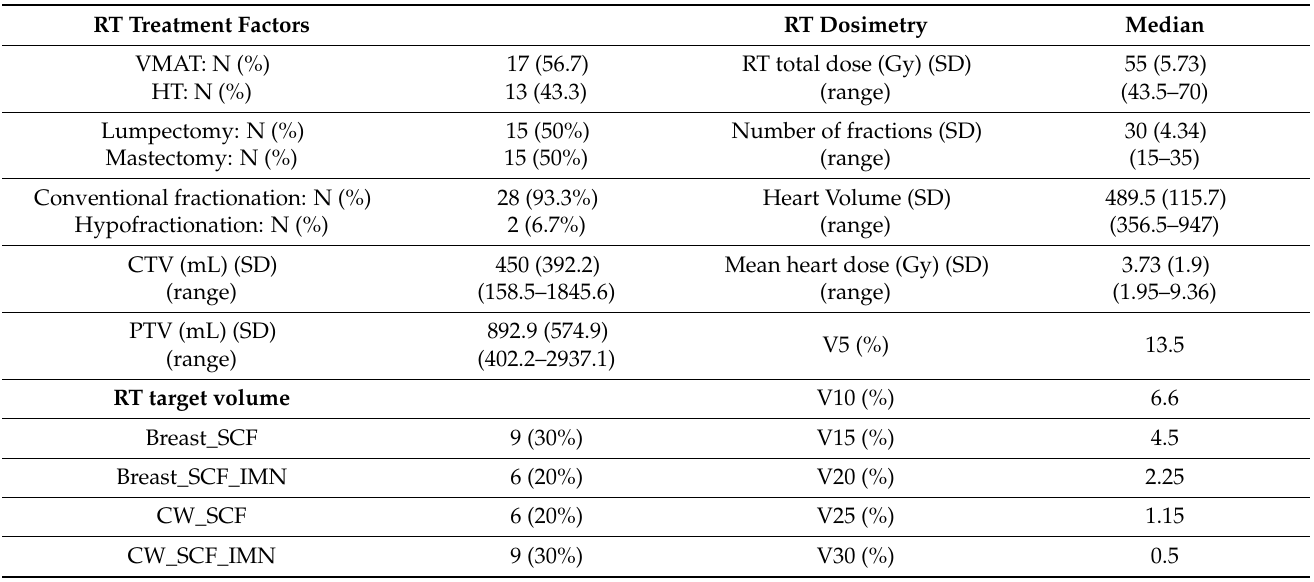
Table 2. RT treatment factors and